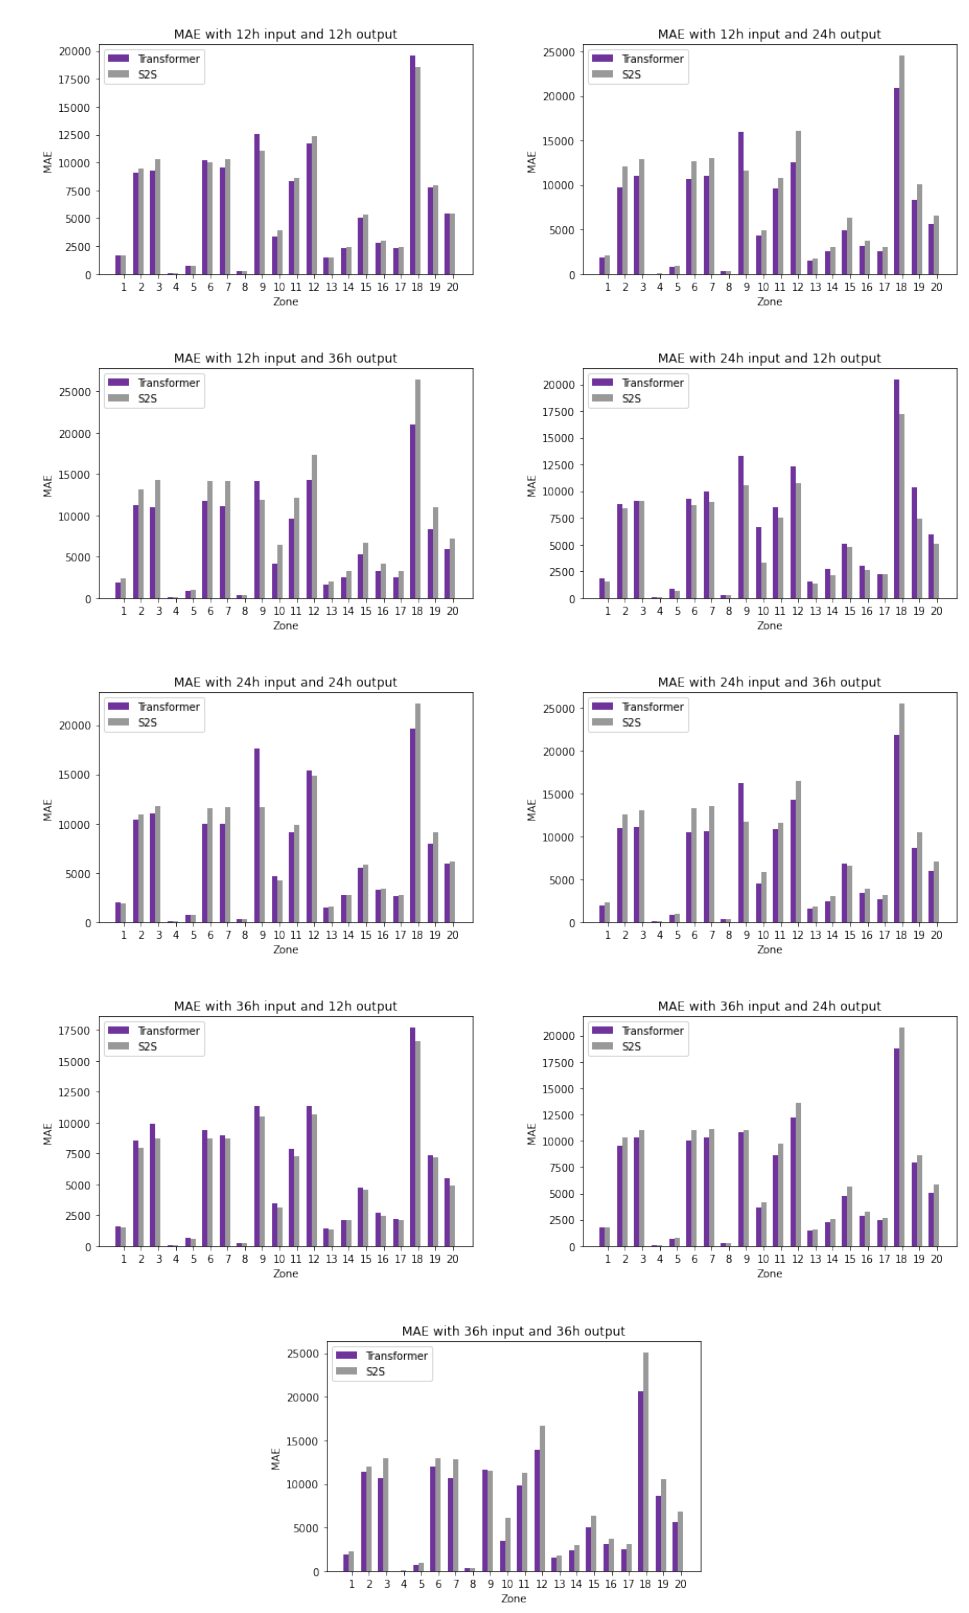
Figure 10. MAE comparison for each stream under each forecasting horizon and input window size between the transformer model and S2S